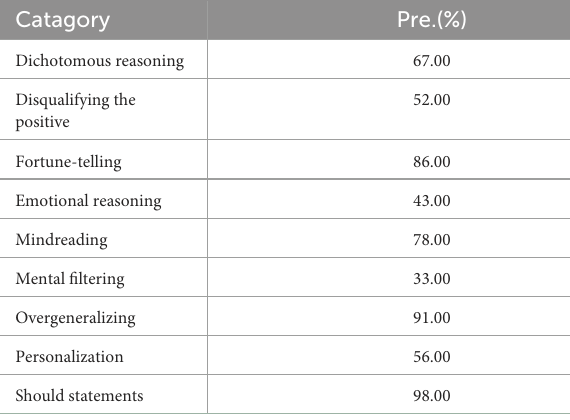
TABLE 4 Percision of manual inspection of pseudo